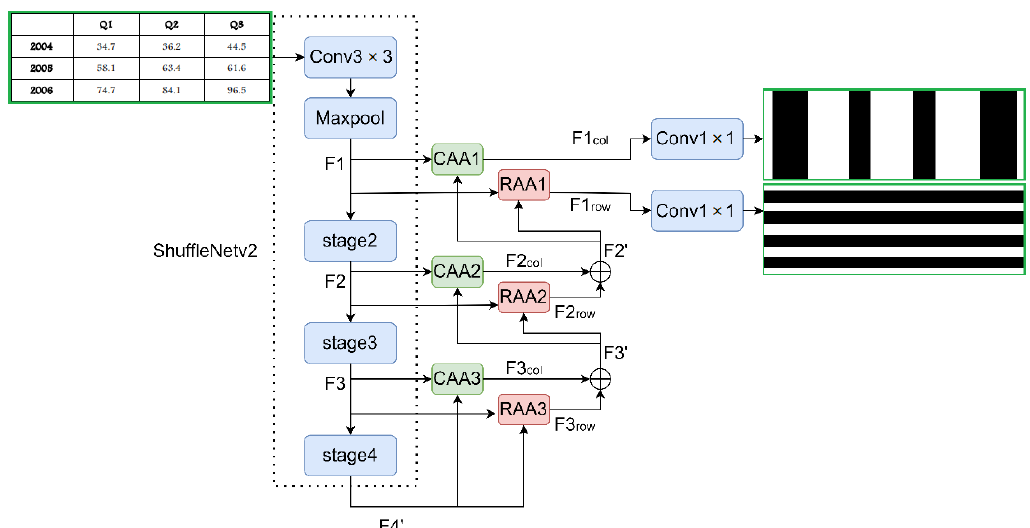
Figure 4. The overall structure of LRCAANet.